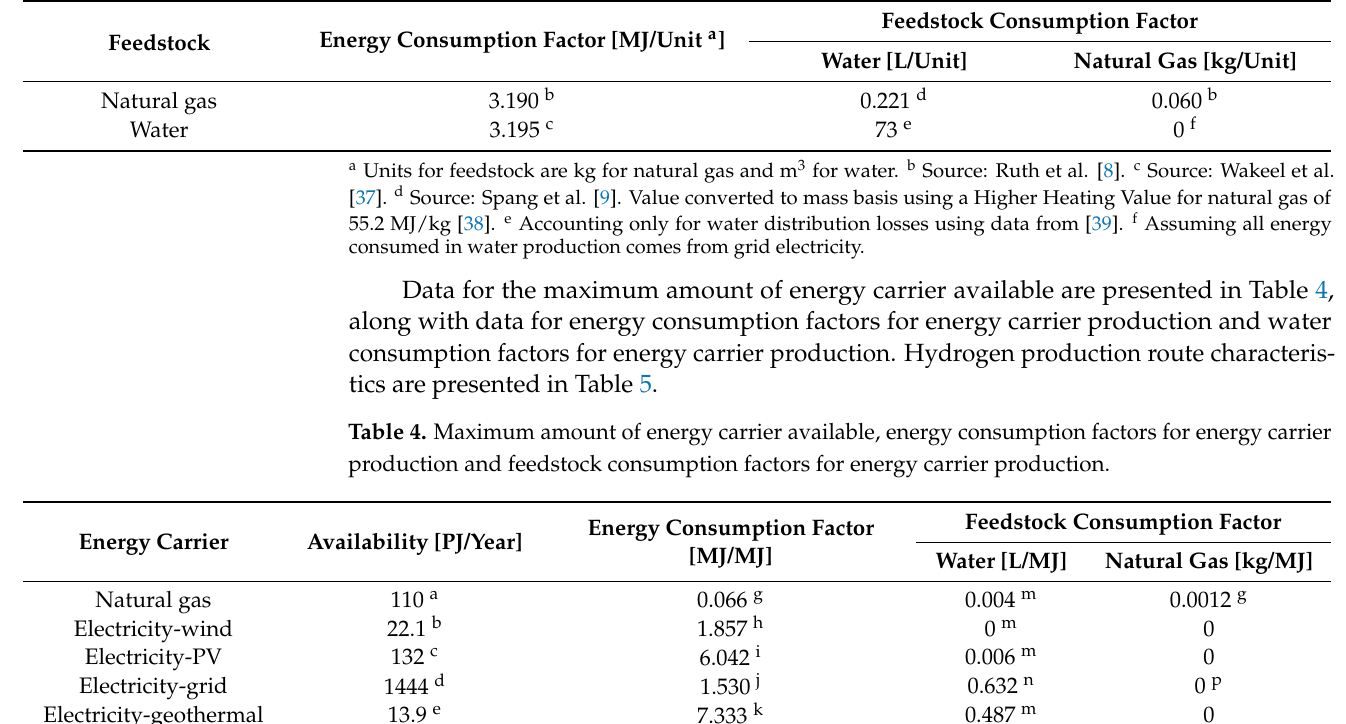
Table 3. Energy consumption factors for feedstock production and feedstock consumption factors for feedstock production.